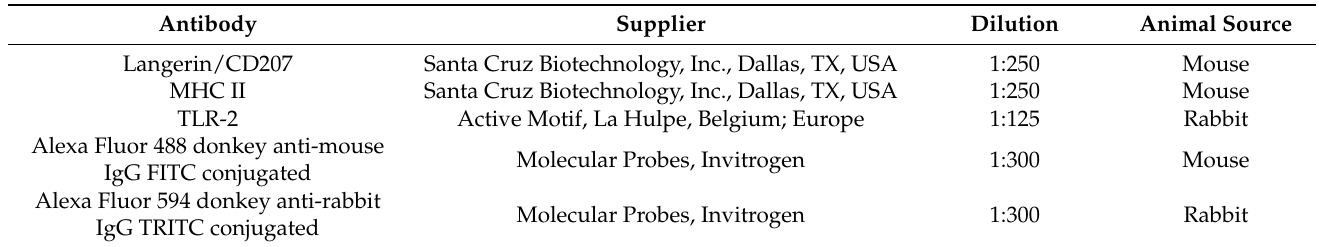
Figure 2. Positive reaction control. Intestine of rat, 40x, scale bars 20 µm. Colocalizations of TLR-2/Langerin/CD207 and TLR-2/MHC II are evident. The “display profile” function confirms the intensity of antibodies colocalization. Table 1. Antibodies